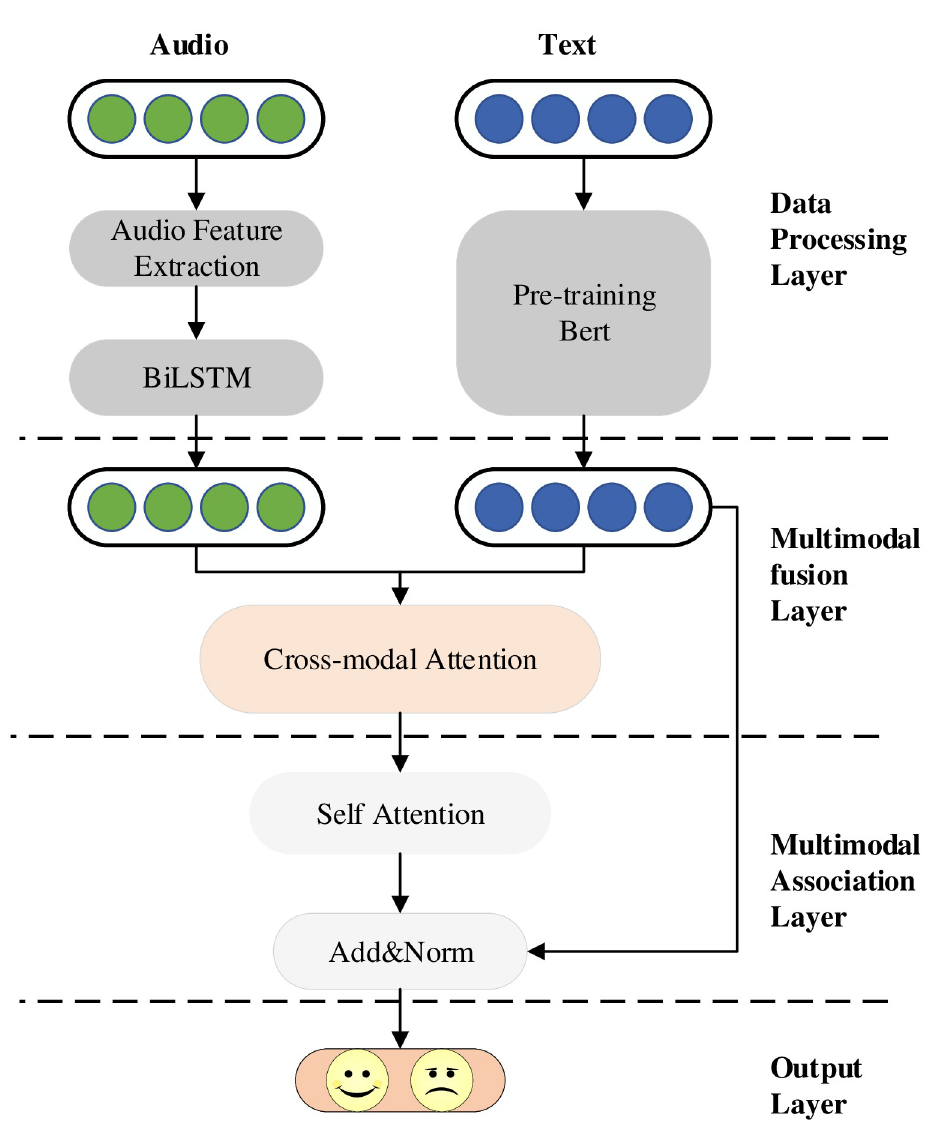
Fig 1. Structure of AFR-BERT multimodal sentiment analysis model. AFR-BERT is divided into four network modules, which correspond to data input, data fusion, data analysis, and data output.